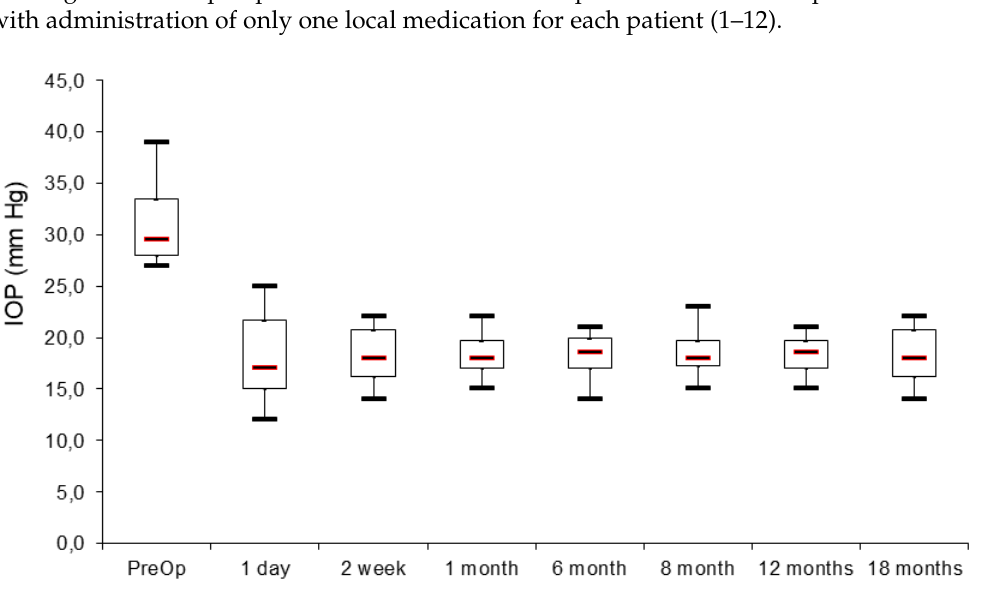
Figure 5. Axis “x” time, axis “y” IOP (mmHg). Figure 6. Scatterplot presents achieved intraocular pressure at 18 months post-inter- 126 vention with administration of only one local medication for each patient (1 – 12). 127